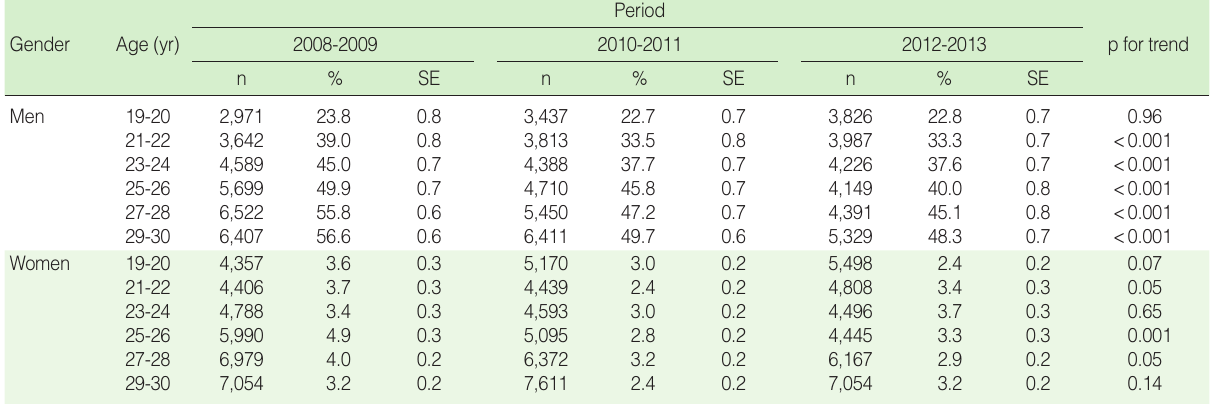
SE, standard error. Table 2. Goodness of fit of APC for smoking prevalence among Korean young adults Gender